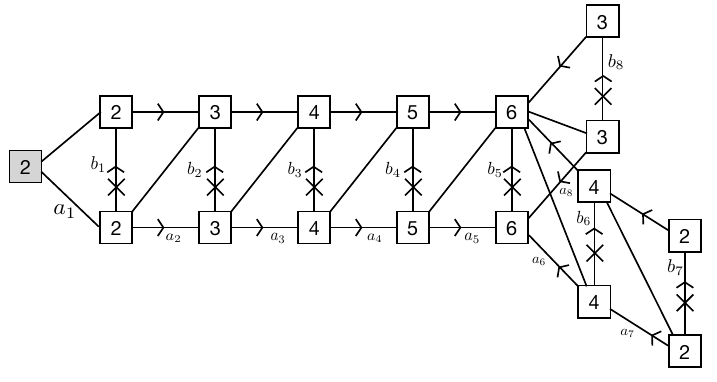
Figure 19 . Basic domain walls in the minimal E 8 theory with D 1 = f + 8 g (cid:12)